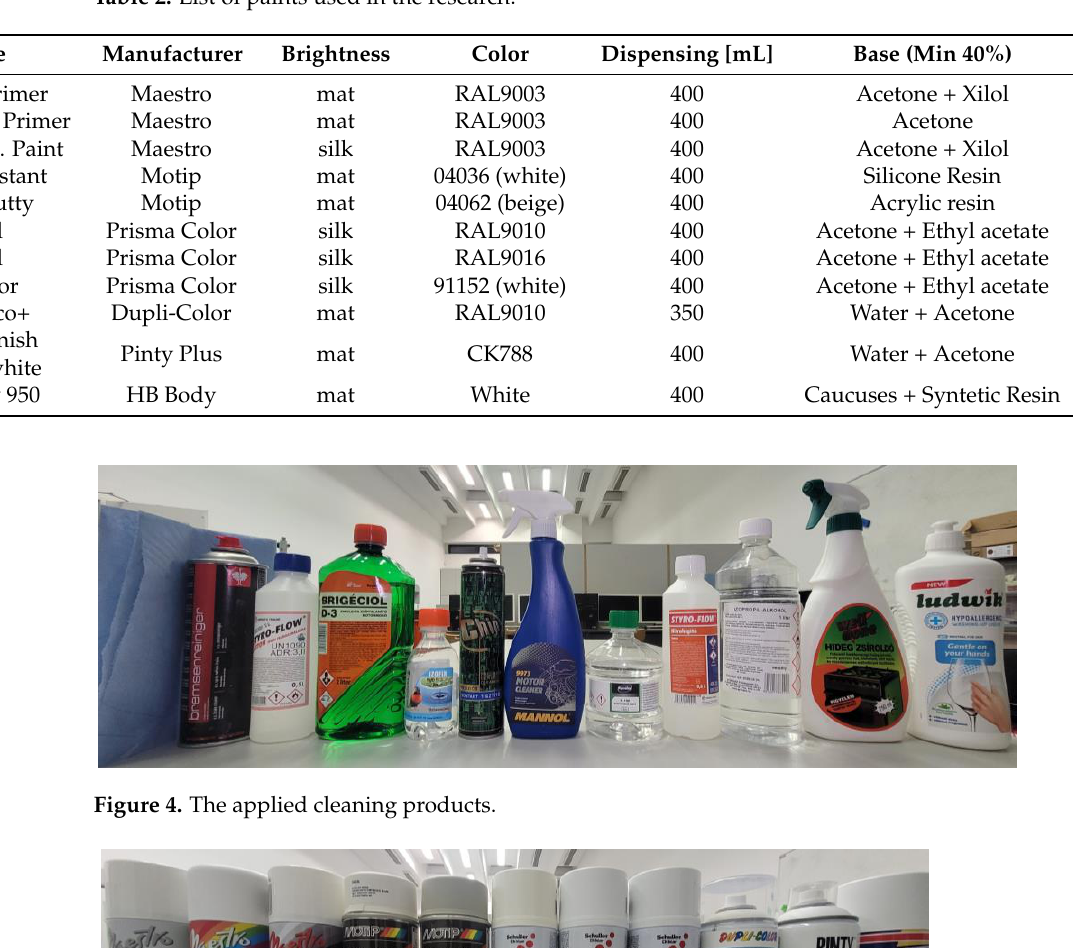
Table 1. Surface preparation materials and processes. Table 2. List of paints used in the research.